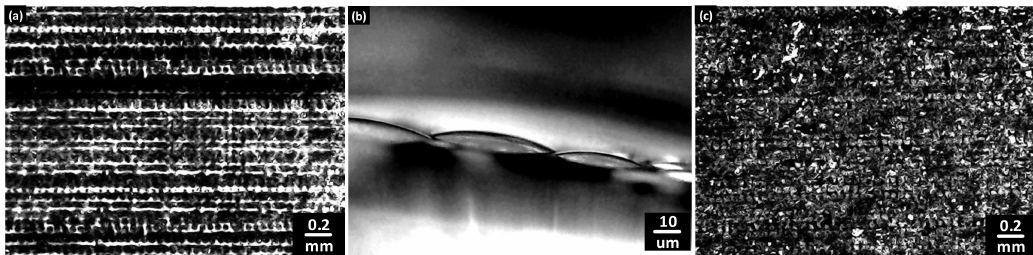
Figure13. Comparisonoftwomethodsusedtoprintthemicrographofthesquareresistance. ( a )Printing scheme outcome without Figure 8b,c. ( b ) Enlarged view of the noted drawback. ( c ) Printing scheme outcome with the method proposed in this study.